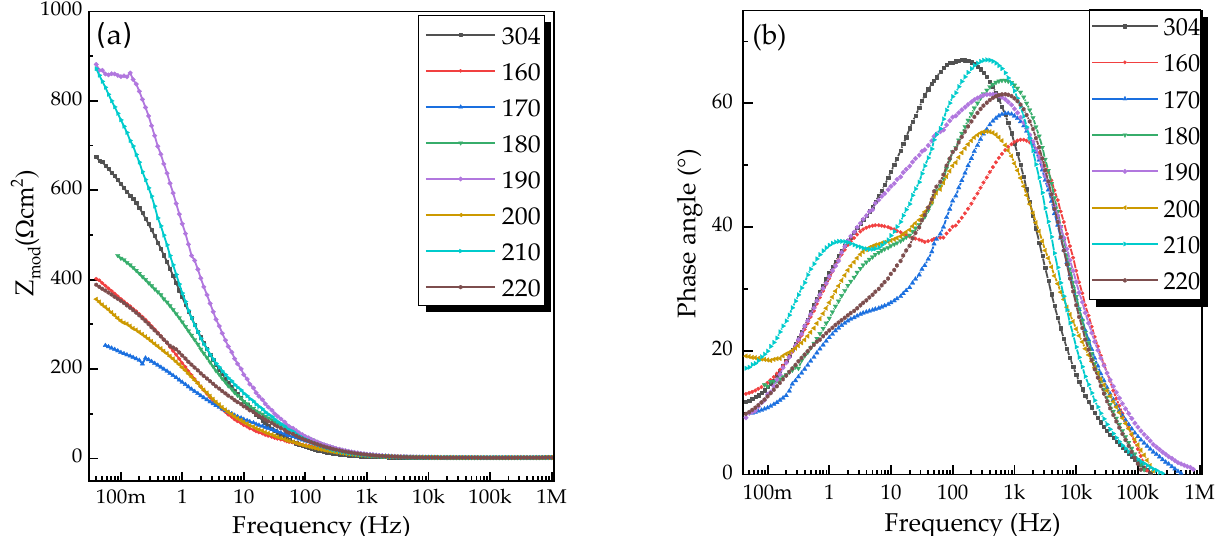
Figure 10. ( a ) Phase module as a function of frequency, ( b ) Phase angle as a function of frequency. The loss of phase shift for some samples at low frequencies represents the loss of the dielectric properties of the substrate in the pores, which makes the accumulation of charge between the two interfaces (coating-electrolyte and substrate-electrolyte) hardly distin- guishable. The attempt to form a significant phase shift at low frequencies shown by sam- ples 170, 180, 190, 200, and 220 W may represent a sudden loss of the passive oxide layer formed in the pores, indicating that the electrolyte reached the substrate much more in- vasively than in the other samples. The diffusion of some reactants such as oxygen through the system depends largely on the type of grain boundaries present in the pores of the coating. For this reason, the microstructure of the coatings is related to the diffusive behavior [58], which could give us indications of a possible columnar structure in samples 170, 180, 190, 200, and 220 W, and an equiaxed or amorphous vitreous structure in samples 160 and 210 W that showed a significant lag. Furthermore, the austenitic 304-steel sub- strate showed highly capacitive behavior only at high frequencies, which gives an indica- tion of its low porosity [59]. 4. Conclusions • The successful synthesis of tantalum nitride has been achieved using the reactive DC sputtering technique and the effect of growth power on phase formation and micro- structure has been investigated to reach an understanding of the growth mechanisms that predominate in the formation of the compound;